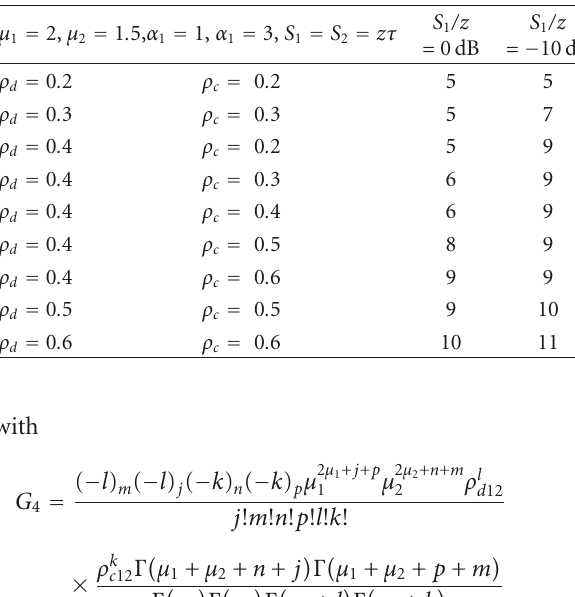
Table 1: Terms need to be summed in (12) to achieve accuracy at the 7th significant digit.